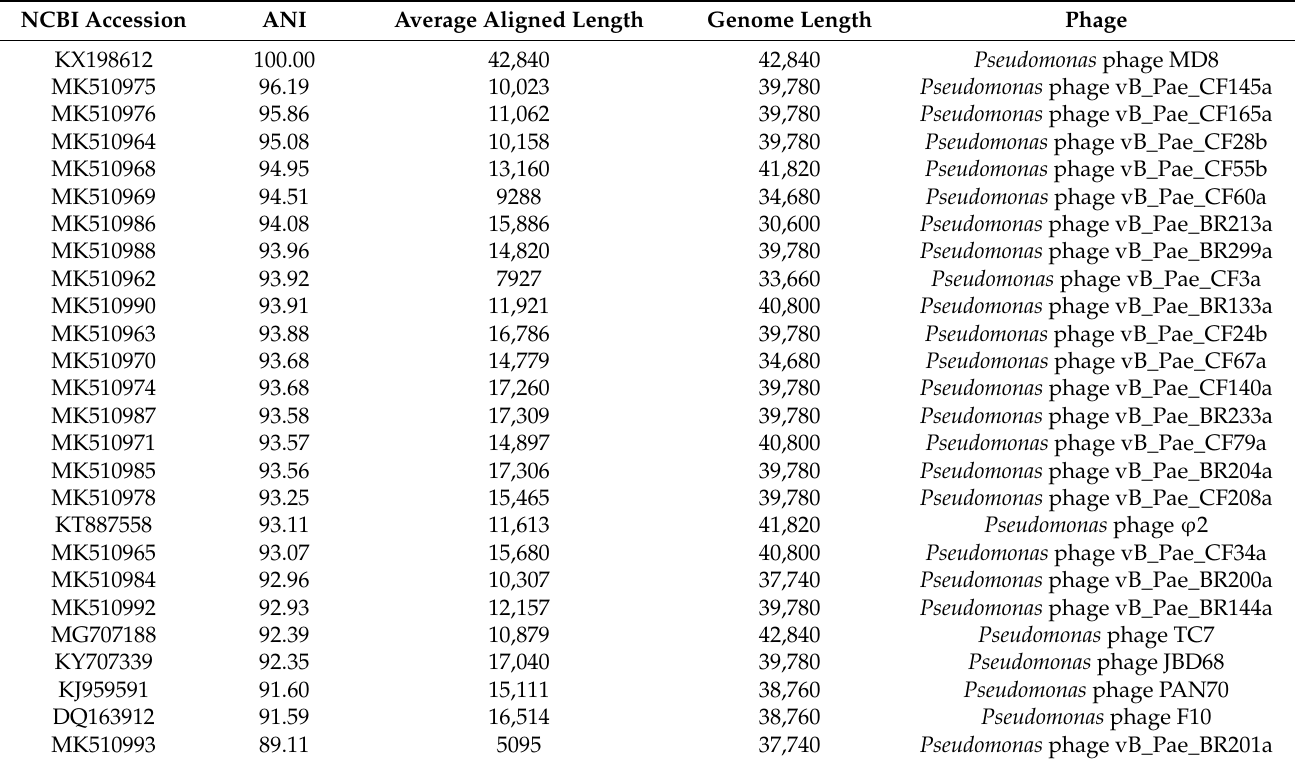
Table 1. ANI values compared to Pseudomonas phage MD8 for all of the 14,983 GenBank phage genomes demonstrating aligned length with MD8 of more than